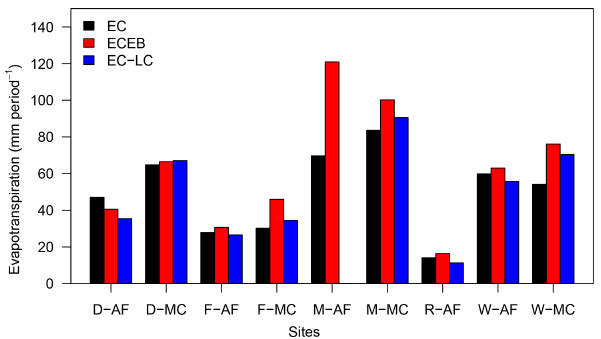
Figure 8. Sums of uncorrected and not gap-filled half-hourly evapo- transpiration for all three methods and all sites during the campaign periods. Sites are abbreviated by their first letter and are identified as being either AF (agroforestry) or MC (monoculture). Incomplete records with ET EC , ET ECEB , or ET EC-LC missing were omitted. Data for ET EC-LC at Mariensee AF are missing due to technical problems with the sensor during the campaign, and all data for Reif- fenhausen MC are missing due to the unavailability of a